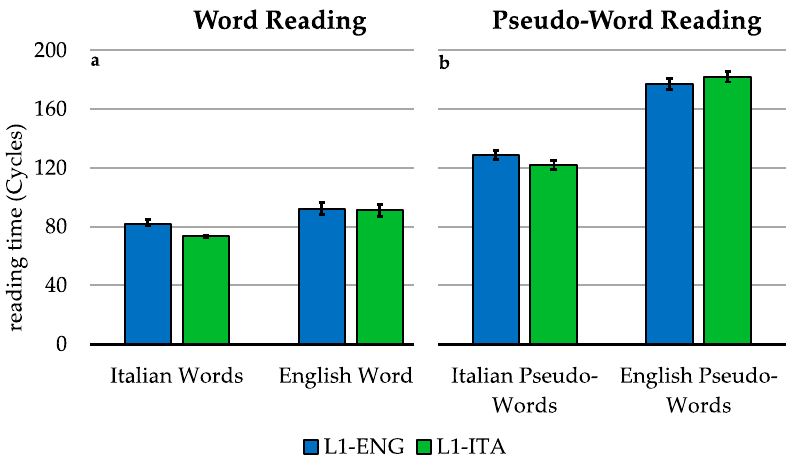
Figure 5. Reading performance of the computational reading models for words ( a ) and pseudo-words ( b ). The color of the bars identifies the L1 of each model. For example, a blue bar for Italian stimuli reflects the performance of a L2-Italian network (“equivalent” to an English bilingual). A green bar for English stimuli reflects the performance of an L2-English network (“corresponding” to an Italian bilingual). To match the human data, the L2-Italian network was trained with 150,000 word presentations; the other networks were trained with 300,000 presentations. See the main text for the caveats on the wording “corresponding”. Error bars indicate the standard error of the mean.